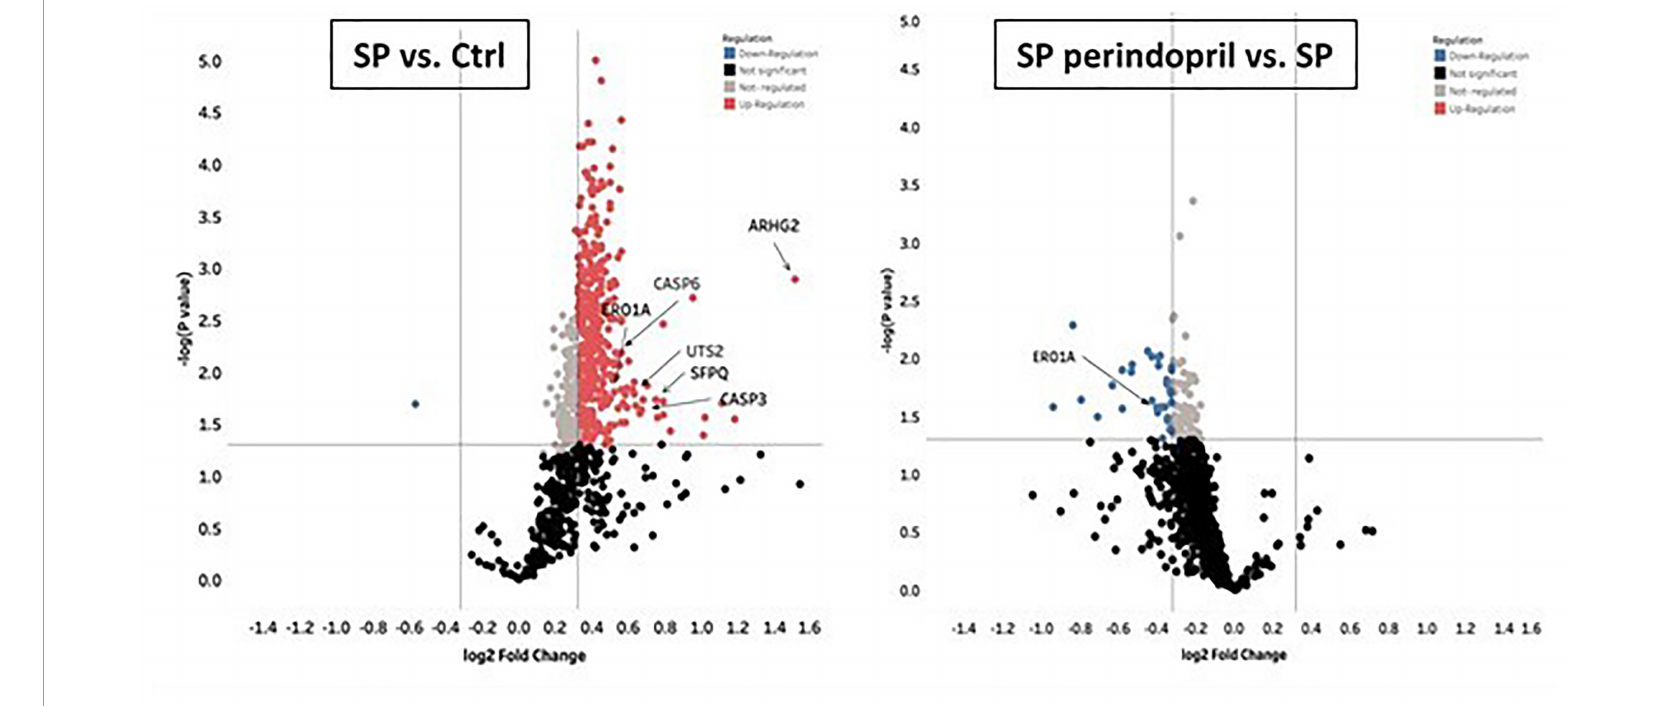
FIGURE 6 | Mass spectrometry analysis of THP-1 macrophages cells stimulated with spike (S) protein. Volcano plot display differentially expressed proteins in cells stimulated with S protein (SP) (100 µM) versus mock treated (Ctrl) or in presence of ACE inhibitor (SP Perindopril, 100 µM): colored circles are signi fi cant proteins (p < 0.05), red is upregulated proteins with fold change ≥ 1.25, and blue is downregulated protein with fold change ≤ 0.83. Student ’ s t-test used for statistical analysis. Gray circles are non-regulated proteins, and black are proteins with non-signi fi cant